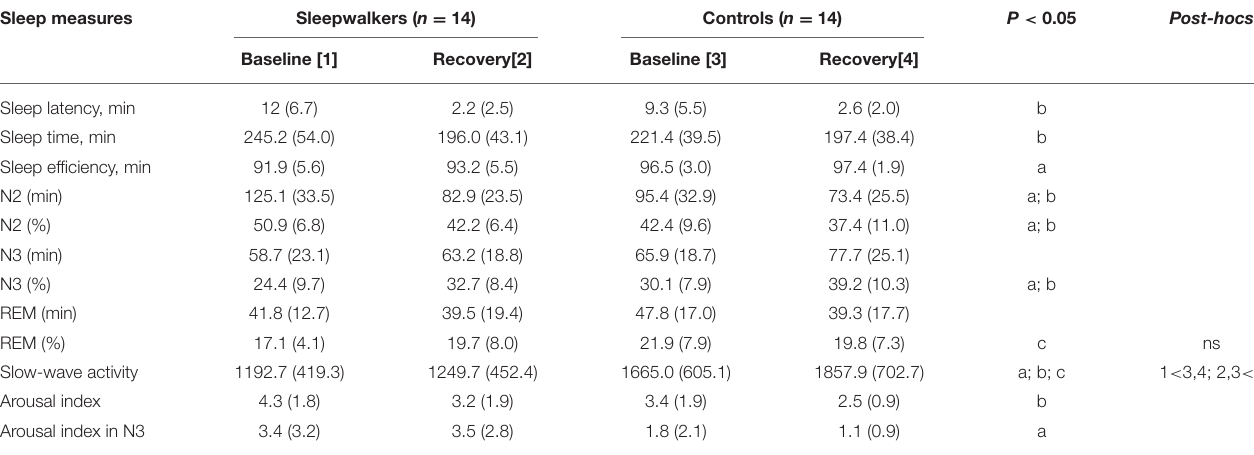
TABLE 1 | Sleep characteristics of sleepwalkers and control subjects from sleep onset to the end of the second sleep cycle. Sleep